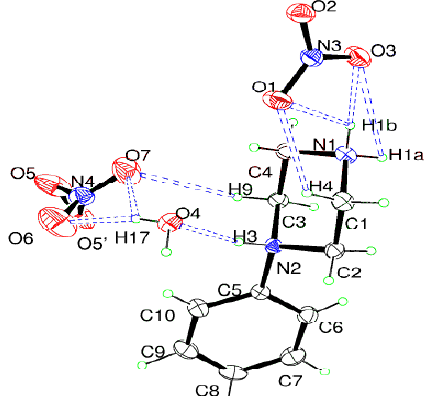
H N ) Figure 2. X-ray Crystal packing of 10 16 2